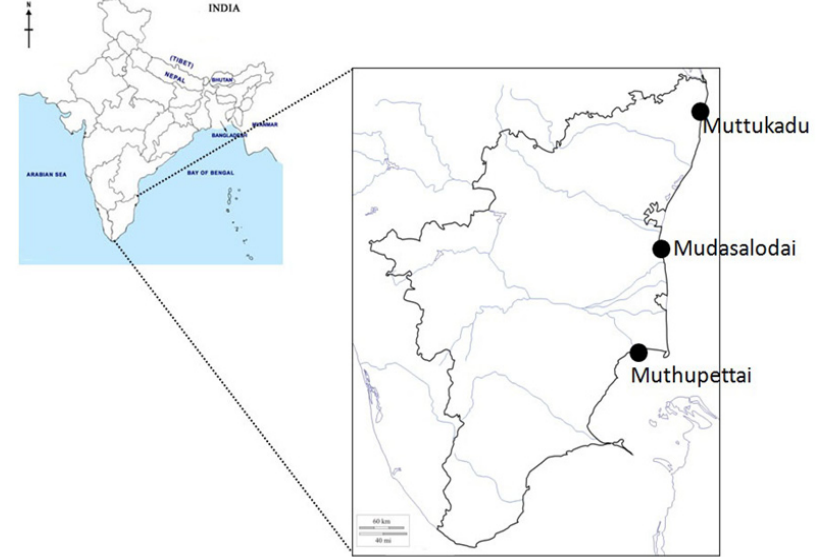
Fig. 1. Map of sample collection sites in Tamil